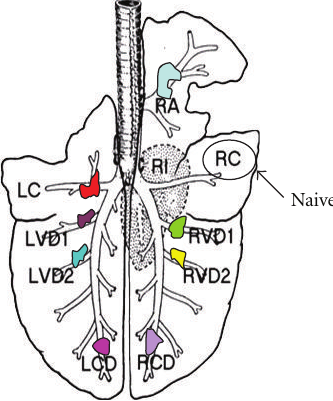
Figure 1: Schematic diagram of the sheep lung with di ff erent compartments that can be manipulated to induce injury at di ff erent time points. Di ff erent colours represent di ff erent time point of endobronchial brush injuries. (LC: left cranial; LCD: left cranial diaphragmatic; LVD1: left ventral diaphragmatic lobe 1; LVD2: left ventral diaphragmatic lobe 2; RA: right apical; RC: right cranial; RCD: right cranial diaphragmatic; RVD1: right ventral diaphragmatic lobe 1; RVD2: left ventral diaphragmatic lobe